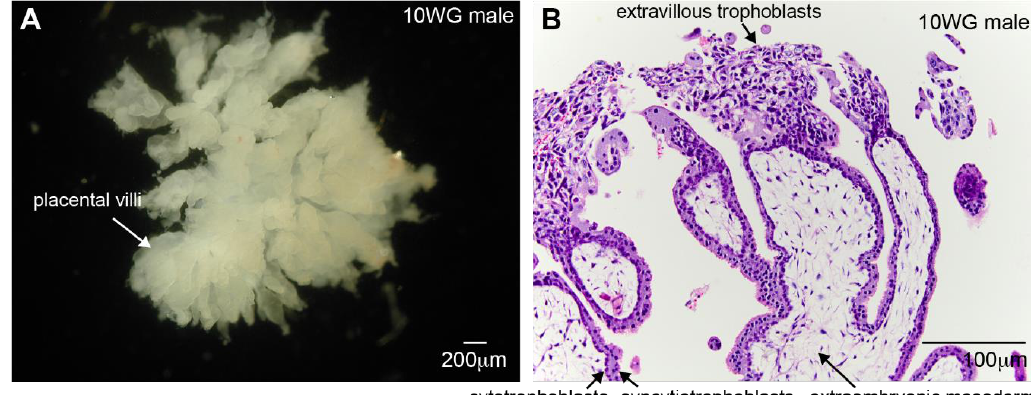
Figure 1. Structure of human placental villi early during pregnancy. ( A ) Photograph of part of the placenta that interfaces with the uterus (top view) containing the tops of the placental villi at 10WG. ( B ) Histological section of placental villi showing the core of extraembryonic mesoderm and the outer layers of cytotrophoblasts (CTBs), surrounded by syncytiotrophoblasts (STBs). The top of the villi contains a column of CTBs, and the extravillous trophoblasts (EVTs) will invade the uterus. The section shows an eosin and hematoxylin staining. Scale bars are 200 micrometers in ( A ) and 100 micrometers in ( B ).